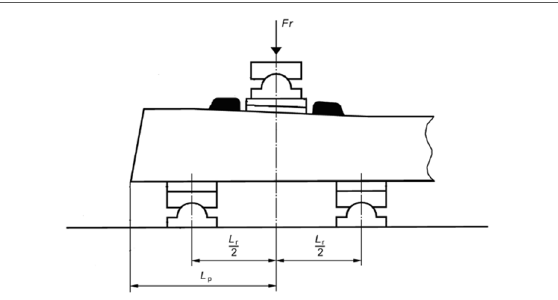
Fig. 7 Values of L r and L p